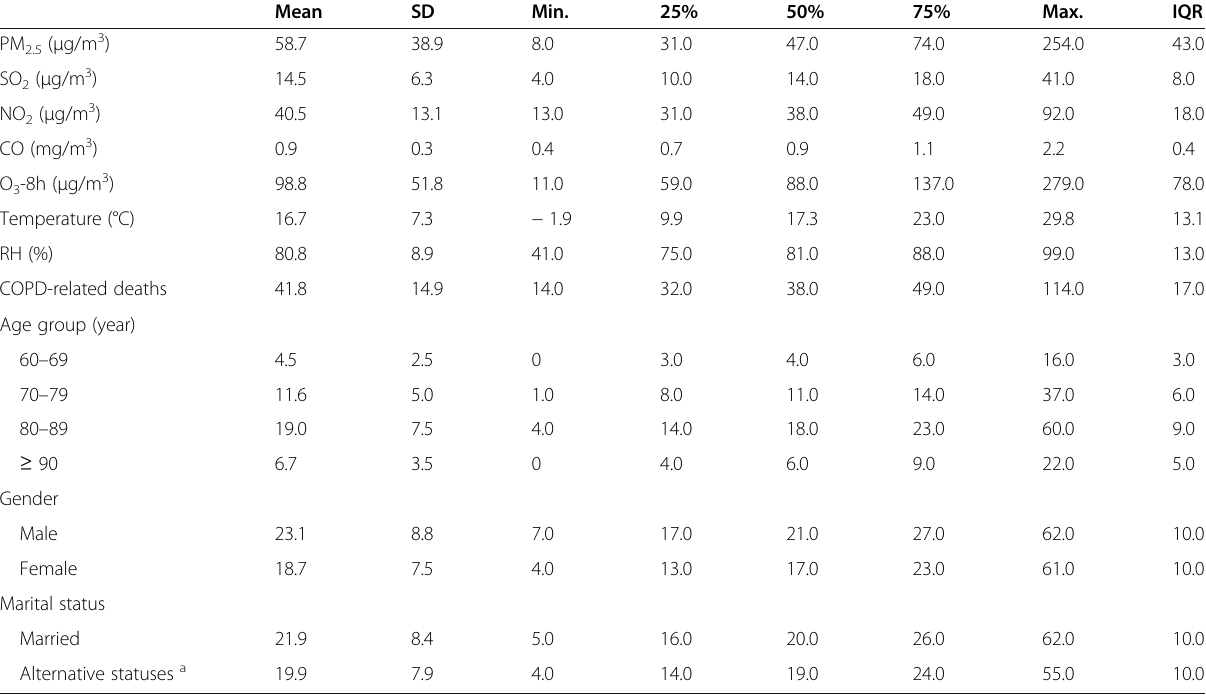
Table 1 Data for ambient air pollutants, weather conditions, and COPD-related deaths in Chengdu from 2015 to 2018